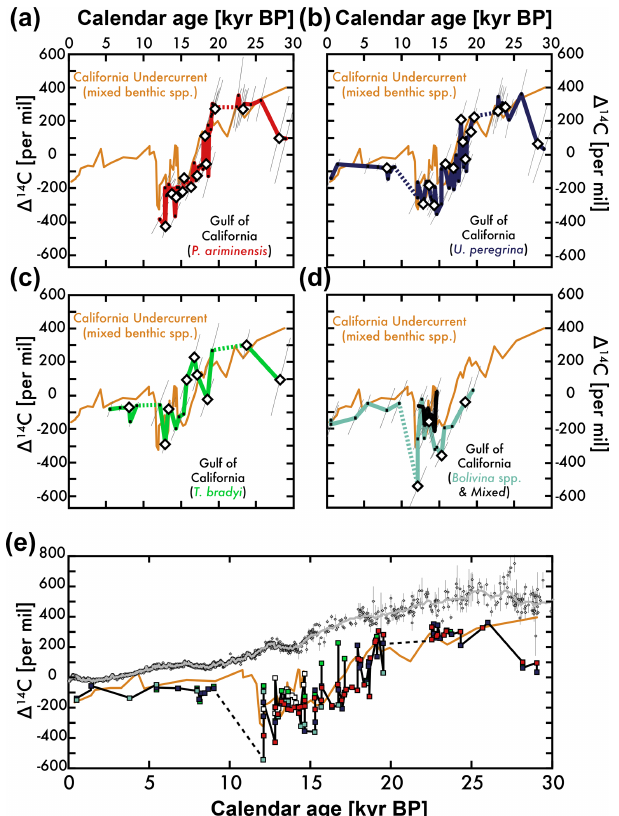
Figure 5. The 14 C isotopic composition (corrected for decay as (cid:49) 14 C) for Gulf of California benthic foraminifera monospecies (a– d) and mixed species (d) compared with monospecies and mixed- species benthic foraminifera (cid:49) 14 C measurements from the Califor- nia Undercurrent sediment core site (orange) (Lindsay et al., 2015; Marchitto et al., 2007) over the past 30000yrBP. See core loca- tions in Fig. 2. Canted error bars take into account measurement and age model errors (Stuiver et al., 2017). Diamonds indicate (cid:49) 14 C at foraminifera abundance maximum. The (cid:49) 14 C of all gulf benthic foraminifera (see Fig. 3 legend) is shown (e) alongside atmospheric (cid:49) 14 C (gray) (Reimer et al., 2013) and California Undercurrent site (cid:49) 14 C (orange). Modern (cid:49) 14 C near the depth of the gulf and Pacific sites is about − 173‰ (Key et al., 2004).